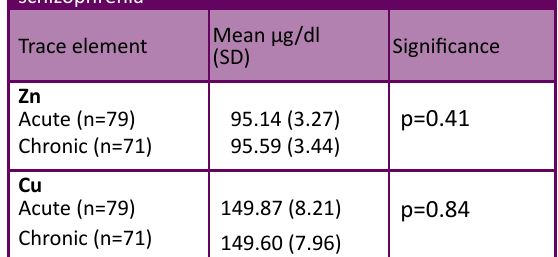
Table 2. Serum Zn and Cu levels in case and control groups Trace element